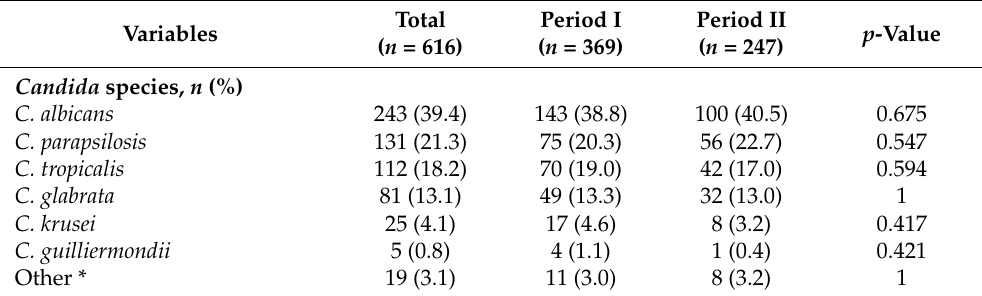
Table 2. Microbiological characteristics of 616 adult patients with candidemia diagnosed at tertiary hospitals in Brazil during Period I: 2010–2011 vs. Period II: